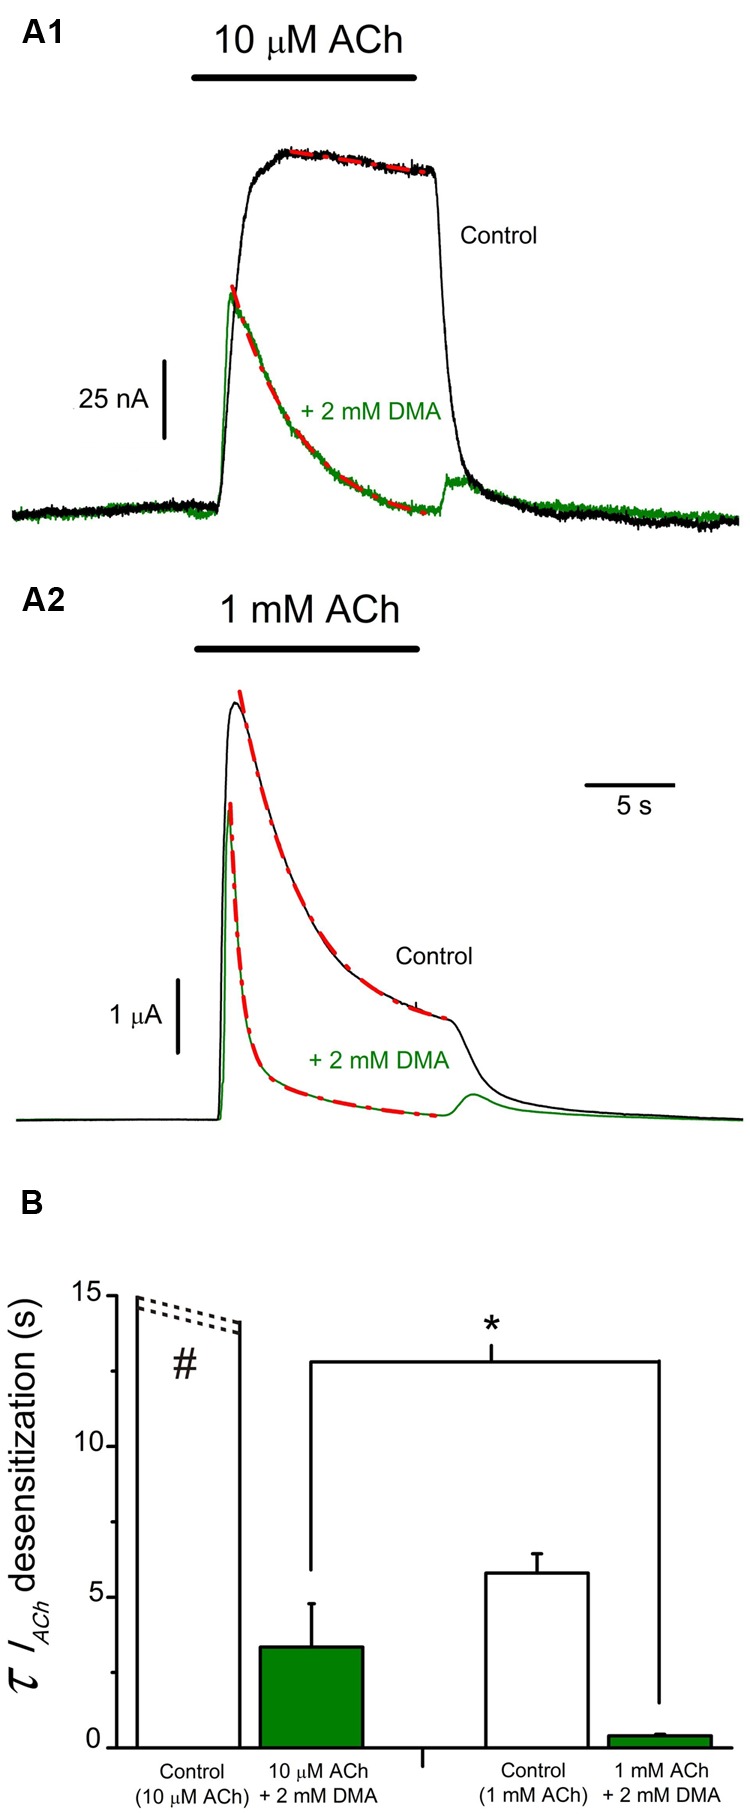
IACh decay hastening elicited by DMA is dependent on ACh concentration. (A) Superimposed recordings of IAChs elicited by 10 μM (A1) or 1 mM (A2) ACh either alone (black recordings) or co-applied with 2 mM DMA (green recordings) in oocytes with the membrane potential held at +40 mV. IACh decays were fitted to exponential curves (red discontinuous lines) and the time constant (τ) values for each group were determined. (B). Column graph of τ values for IACh decays. Data of each column are mean ± SEM from 4 to 6 oocytes (N = 3). When co-applying DMA and 1 mM ACh, the IACh decay was best fitted to double exponential curves and the τ value shown in B corresponds to the fast component. Note that both control IACh amplitude and desensitization rate increased with ACh concentration (see black recordings in A1,A2; B, open columns) and mind the presence of rebound-currents when ACh and DMA were co-applied (green records), independently of the ACh dose used. Observe that DMA co-application caused a stronger blocking effect at low (A1) than at high (A2) ACh concentrations and that DMA enhancement of the rate of IACh decay was greater for higher ACh doses (compare recordings of A1, A2; B). The asterisk indicates significant differences between both DMA groups (p < 0,05, t-test), and the pound sign denotes that this column is truncated, because IAChs elicited by 10 μM ACh showed almost no desensitization.